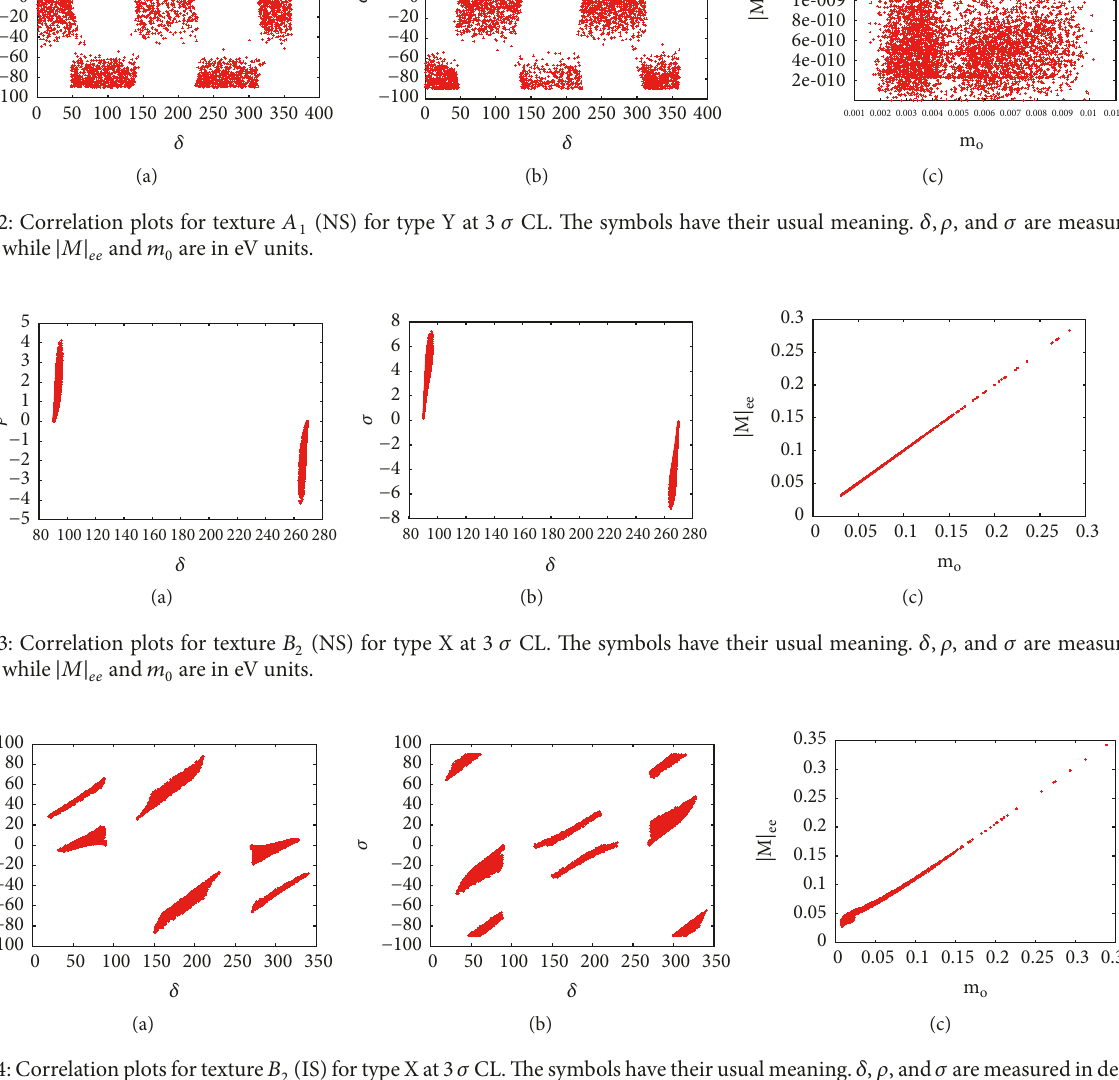
Figure 4: Correlation plots for texture 𝐵 2 (IS) for type X at 3 𝜎 CL. The symbols have their usual meaning. 𝛿, 𝜌 , and 𝜎 are measured in degrees, while |𝑀| 𝑒𝑒 and 𝑚 0 are in eV